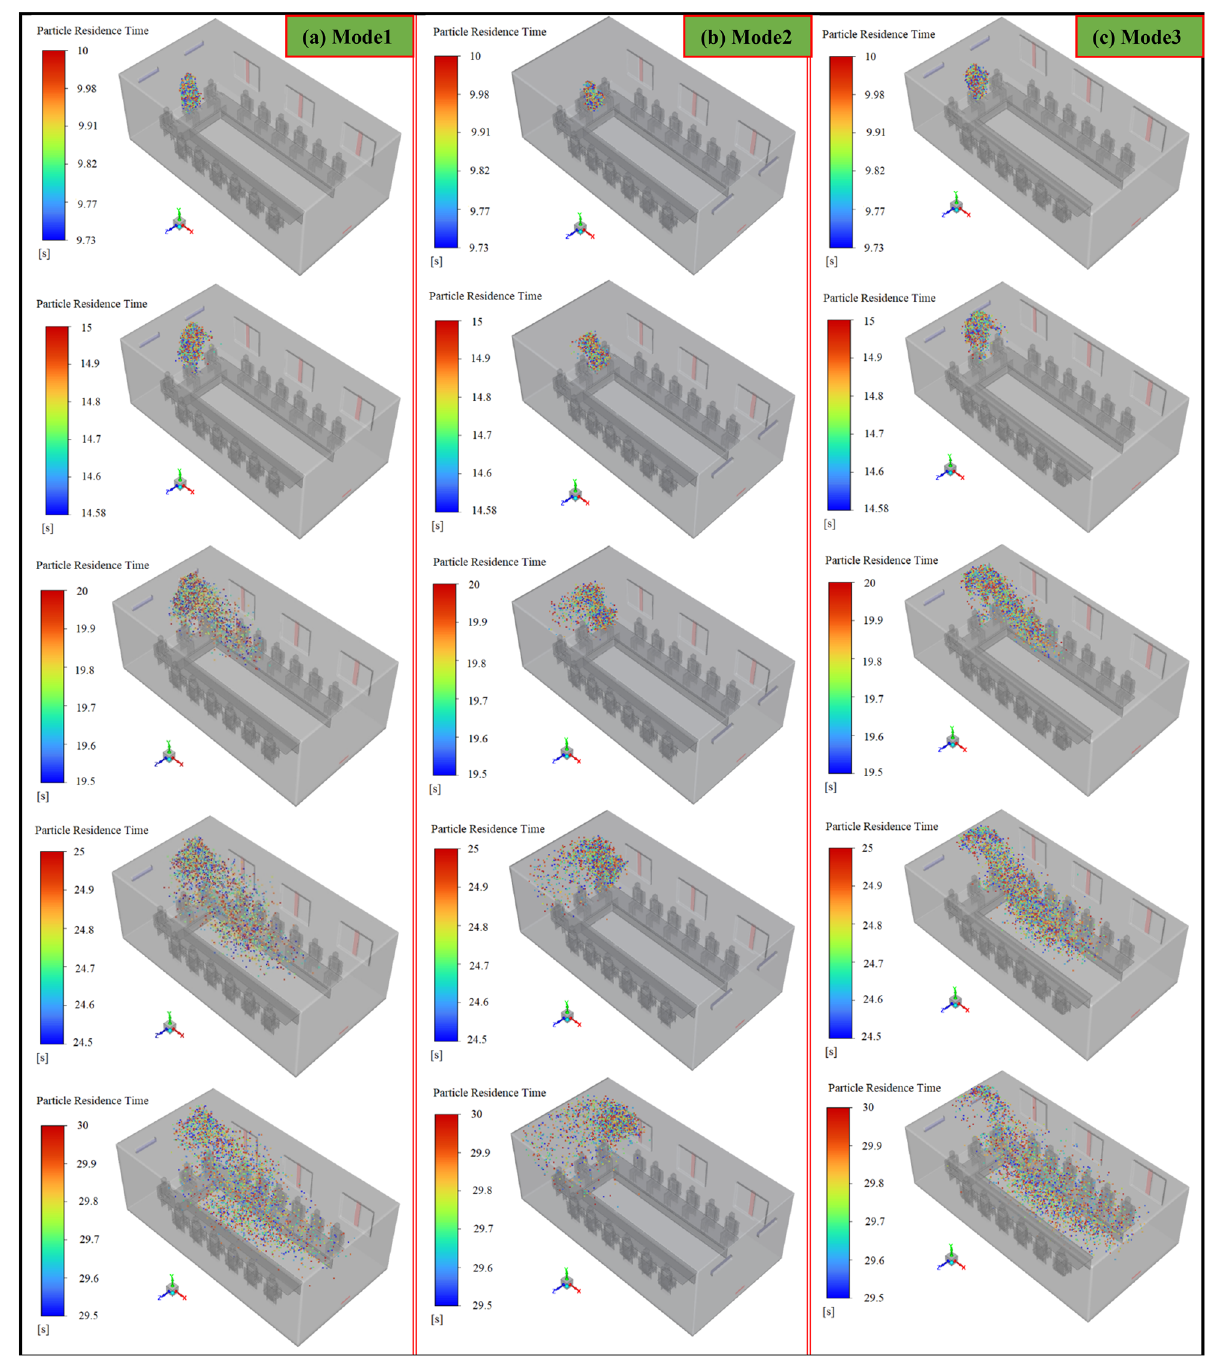
Figure 19. Aerosol cloud profiles at eight instances of time (10–150 s) inside the meeting room for different scenarios: ( a ) scenario 11 (mode 1), ( b ) scenario 12 (mode 2), and ( c ) scenario 13 (mode